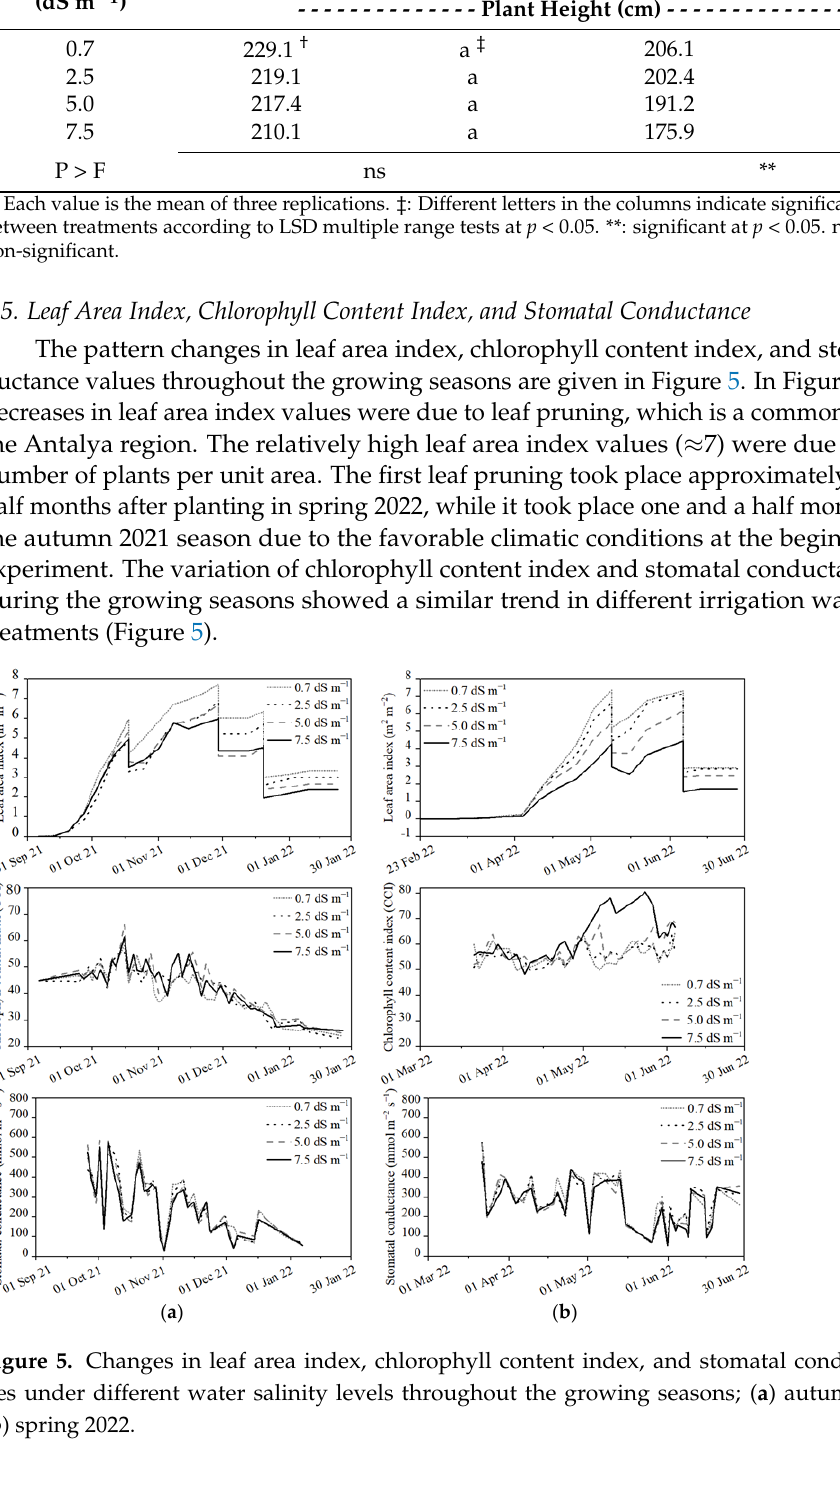
Table 4. The effect of irrigation water salinity on plant height at the end of the growing season. Water Salinity